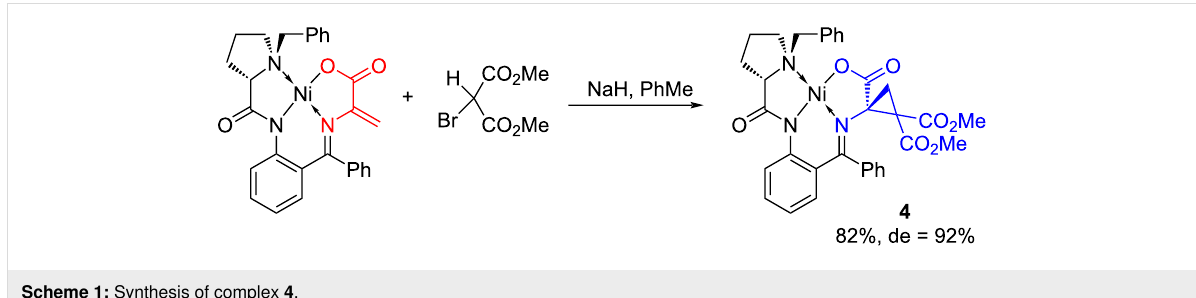
Scheme 1: Synthesis of complex 4 .